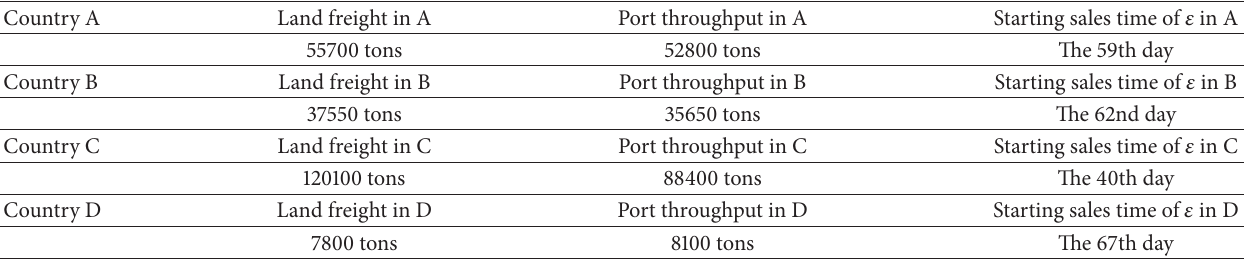
Table 3: Simulation results of freight volume and period in Scheme 1.